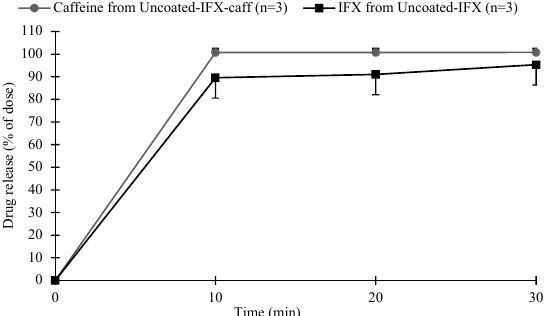
Figure 5. The average ± SD IFX ( n = 3) and caffeine ( n = 3) release profiles from Uncoated-IFX and Uncoated-IFX-caff, respectively, in the simulated ileum medium (pH 7.5) of the GISS.